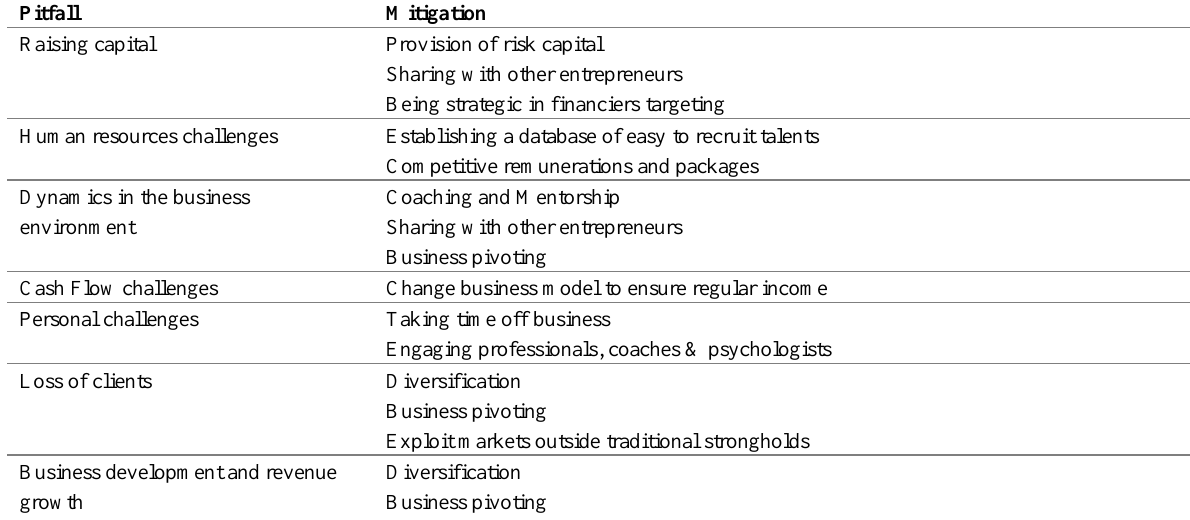
Table 3: Mitigations to Startup Challenges by